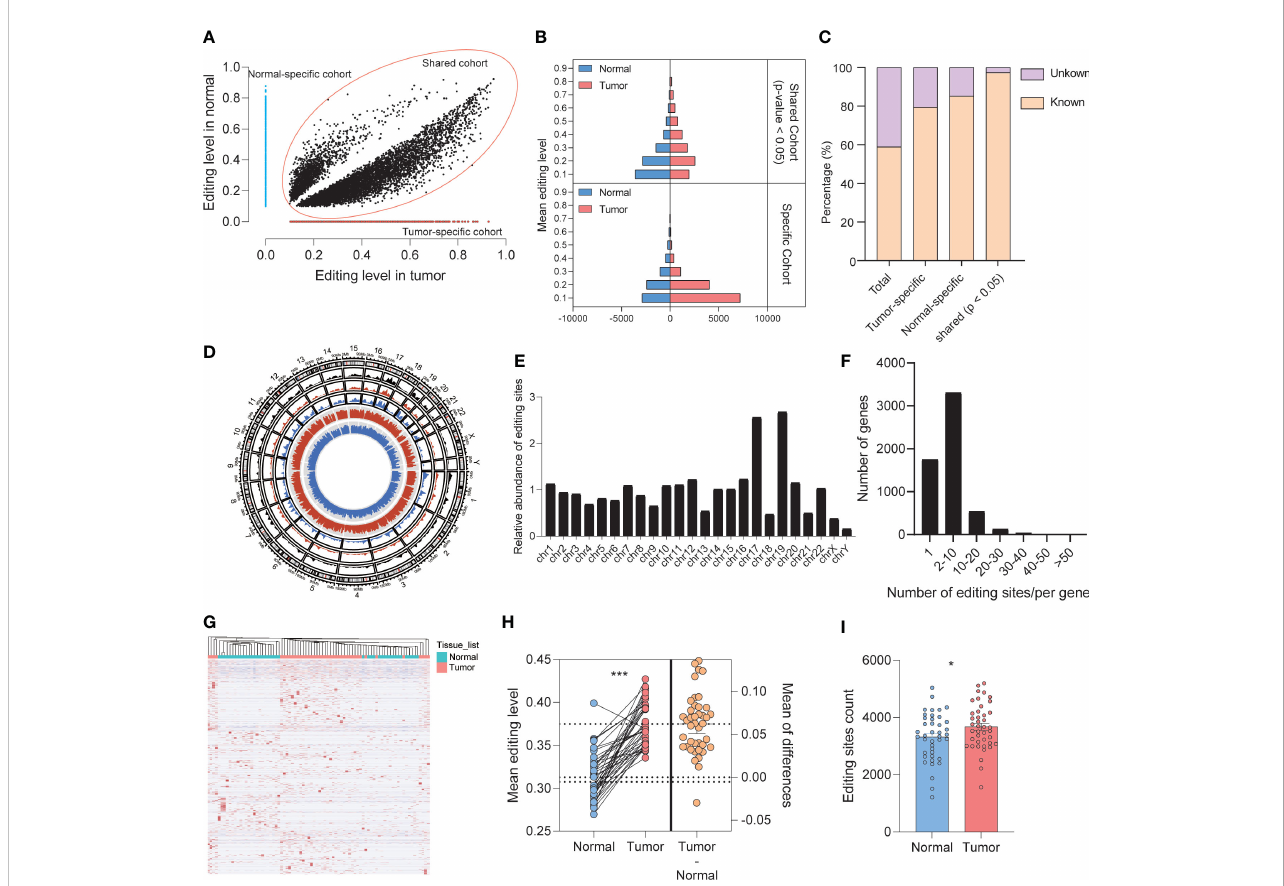
FIGURE 2 Identi fi cation and patterns of different A-to-I RNA editing sites. (A) The distribution of mean editing level on DREs among three groups. (B) The distribution of DREs ’ editing level between normal and tumor samples. (C) Comparison of editing events with REDIportal including huge known editing events. (D) The circos diagram displayed the distribution of DREs among chromosomes. The black, red, and blue areas showed the density of DREs in the shared, tumor-speci fi c, and normal-speci fi c groups, respectively. The red and blue lines in the center displayed the editing level of each DRE. (E) The overall distribution of DREs upon chromosomes. (F) The overall distribution of DRE count located in one gene. (G) Heat map showing that DREs can effectively distinguish normal tissues from tumors. (H) The mean editing level of DREs in paired tumor and normal tissues. (I) The editing sites count of DREs in normal and tumor tissues. *p < 0.05, ***p <